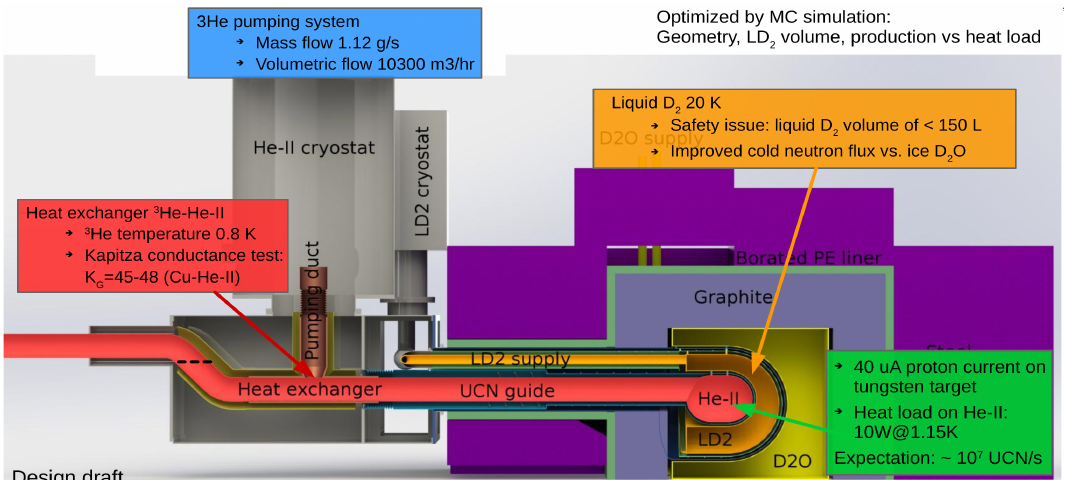
Figure 3. Draft design of the new ultra cold neutron (UCN) source at TRIUMF. The superfluid helium (He-II) UCN production volume is kept below 1.15 K during target irradiation causing a heat load of about 10 W. Cooling of He-II inside the 34 L production volume and a long UCN guide is